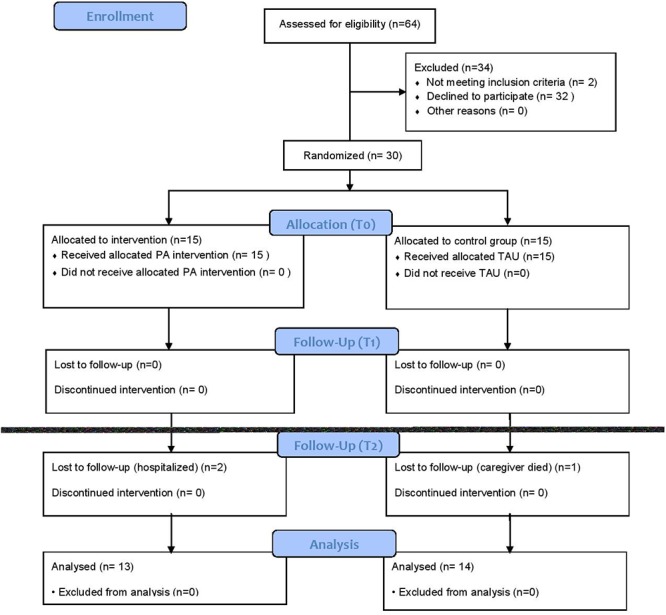
Consort Flow Chart.